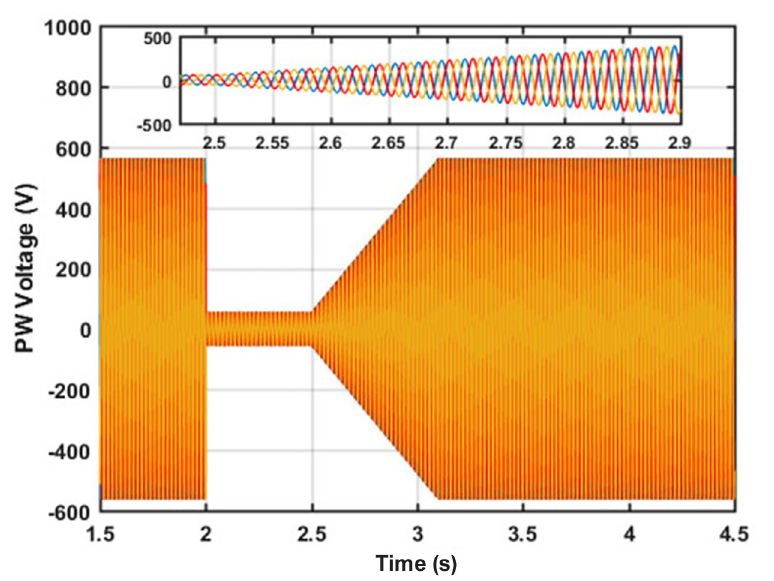
Fig 8. Voltage waveform during the fault